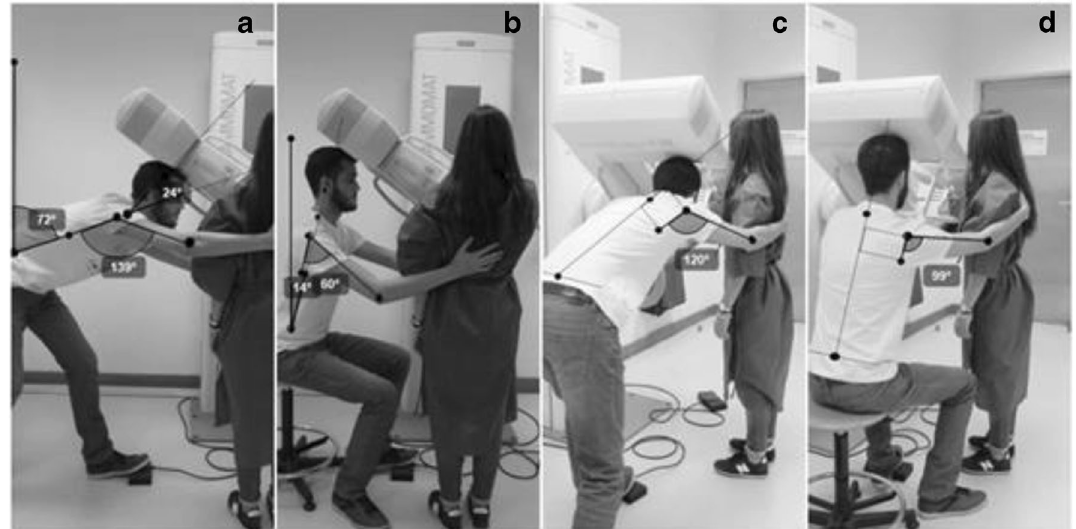
Fig. 6 MLO breast positioning: a and c radiographer postures without intervention; b and d alternative postures when the radiographer is taller than the patient